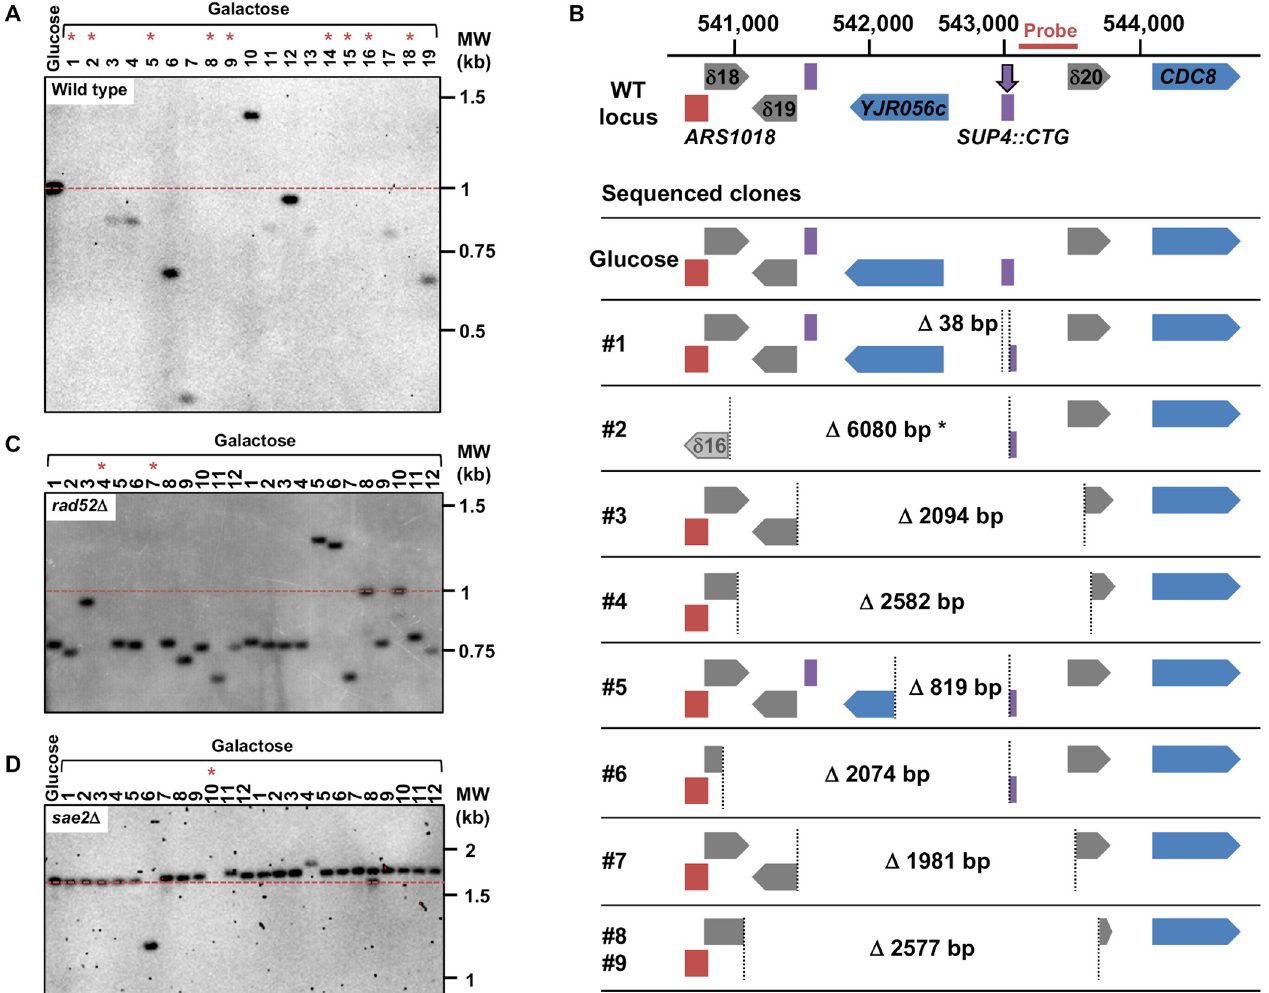
Fig 3. Chromosomal rearrangements following Sp Cas9 induction. A : Southern blot of genomic DNA at the SUP4 locus in the wild-type strain. The probe hybridizes ~300 bp downstream the repeat tract (see Fig 3B). The dotted red line shows the initial length of the CTG repeat tract. The lane labeled "Glucose" contains a clone in which Cas9 was not induced. Lanes numbered #1 through #19 contain independent clones in which Cas9 was induced. Asterisks point to lanes in which no signal was detected, meaning that the probe containing sequence was deleted. Note that signal intensities varies among lanes, showing that the probe did not fully bind to its target sequence, due to its partial deletion. B : Some examples of chromosome rearrangements following Cas9 induction in the wild-type strain. The genomic locus surrounding SUP4 is shown on top, ARS1018 is drawn in red, delta elements are in grey, protein-coding genes are colored in blue and tRNA genes in purple. The DSB (vertical purple arrow) is induced within SUP4 ::(CTG)n. Chromosome coordinates are indicated above and the probe used for hybridization is represented by an horizontal red bar. The locus sequence was retrieved from the Saccharomyces Genome Database (http://yeastgenome.org/, genome version R64-2-1, released 18th November 2014). Under the reference locus are cartooned the different chromosomal structures observed in some of the survivors. A yeast colony that was grown in glucose was also sequenced as a control. For each clone, vertical dotted lines represent junctions of rearrangements observed, with deletion sizes indicated in base pairs. Asterisk: clone #2 showed a complex rearrangement with a local inverted duplication involving the δ 16 LTR and the 3’ end of the KCH1 gene 5 kb upstream SUP4 . Two clones (#8 and #9) exhibit exactly the same chromosomal deletion at precisely the same nucleotides. Note that CDC8 is an essential gene. C : Southern blot of genomic DNA at the SUP4 locus in the rad52 Δ strain. Legend as for Fig 3A. D : Southern blot of genomic DNA at the SUP4 locus in the sae2 Δ strain. Legend as for Fig 3A. Note that for this Southern blot genomic DNA was digested with EcoRV (instead of Ssp I, see Methods), therefore the expected CTG repeat length was around 1.8 kb, instead of 1 kb.